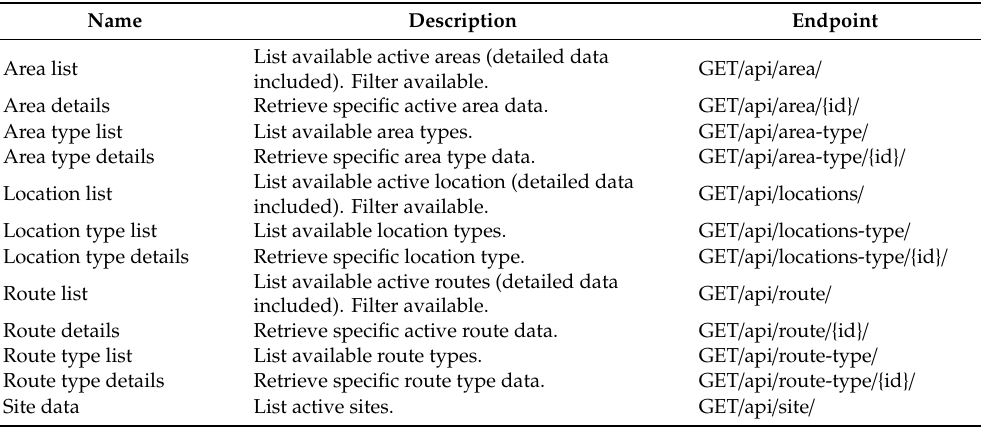
Table 2. Tour organization